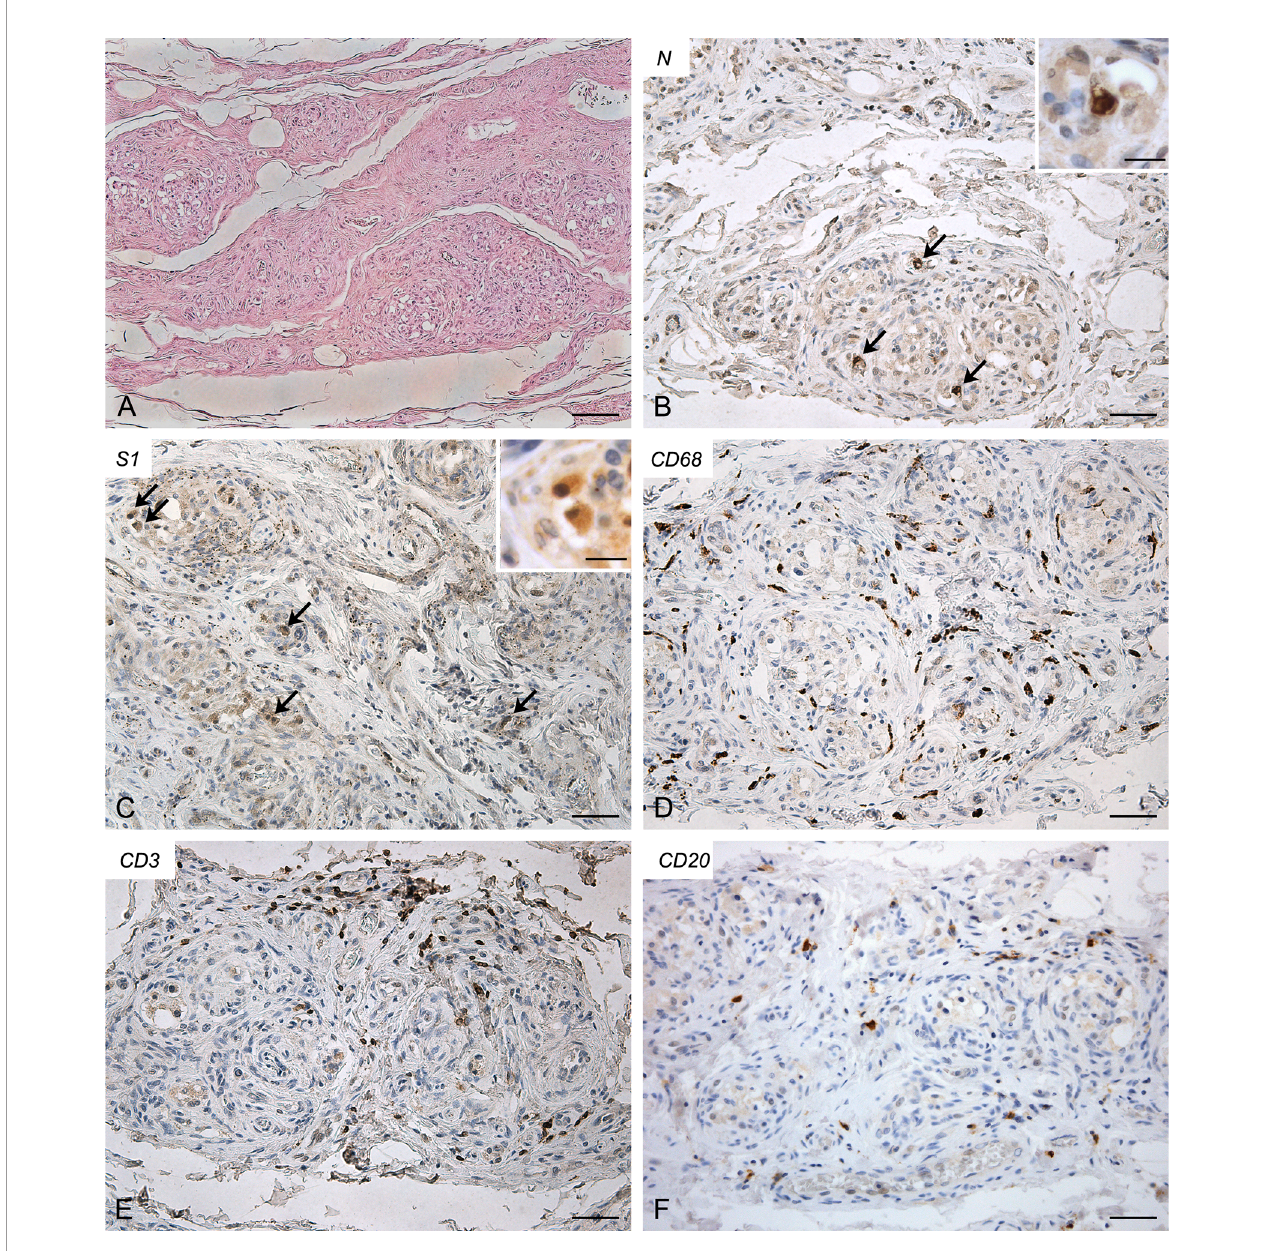
FIGURE 3 | Right carotid body of Case 3 – Haematoxylin-eosin (A) and immunohistochemitries for nucleocapsid ( B,C ; arrows: positive cells), Spike (D) , CD68 (E) and CD3 (F) . Scale bars: 100 µm (A) ; 50 µm (B – F) . Inserts: high magni fi cation of positive type I cells. Scale Bar: 15